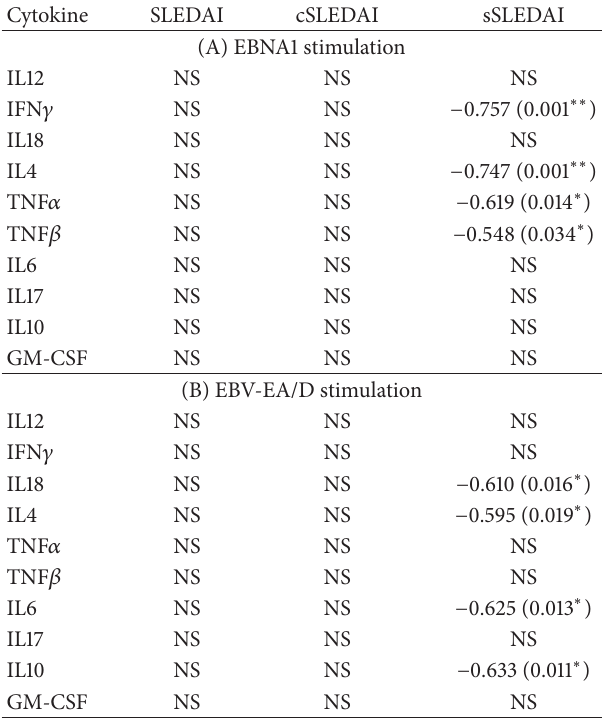
Table4:Correlationbetweeninducedcytokinesanddiseaseactivity of SLE patients ( 𝑛 = 15